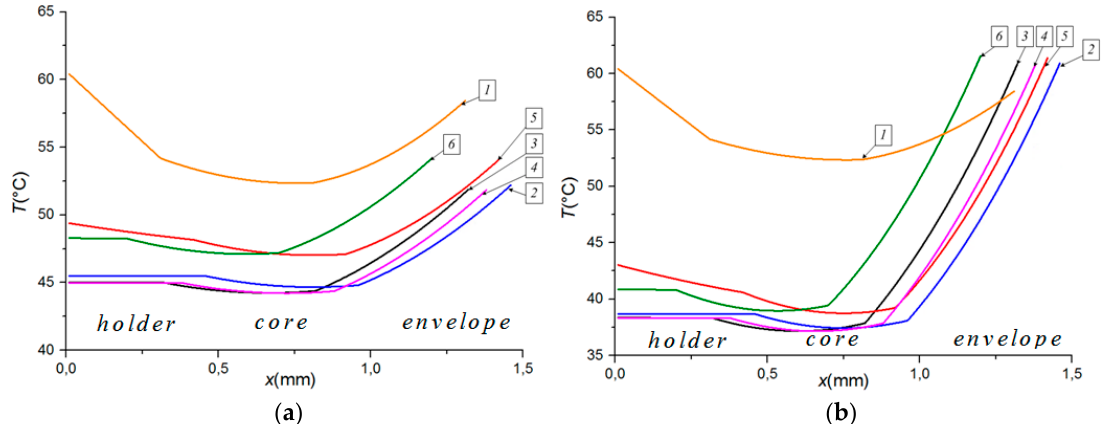
Figure 9. Temperature distributions (along x in a holder–two-component droplet system, see Figure 8) at T a = 300 °C for 10 s ( a ) and T a = 400 °C for 5 s ( b ) using various holders: 1—phosphorus, 2— aluminum, 3—steel, 4—copper, 5—ceramics, 6—nichrome; the holder and droplet dimensions were chosen in line with the conditions of the experiments; the boundaries of areas showing the holder, core, and envelope of a droplet are not marked, since they were slightly different for each of the holders used (see Figure 1).